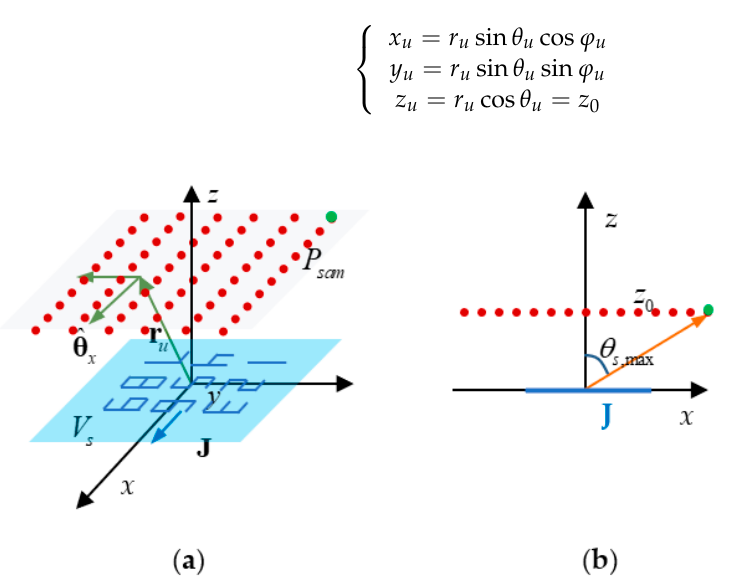
Figure 9. Sample the far-field on a plane. Dots are the sampling points. ( a ) Perspective view; ( b ) side view with ϕ = 45 ◦